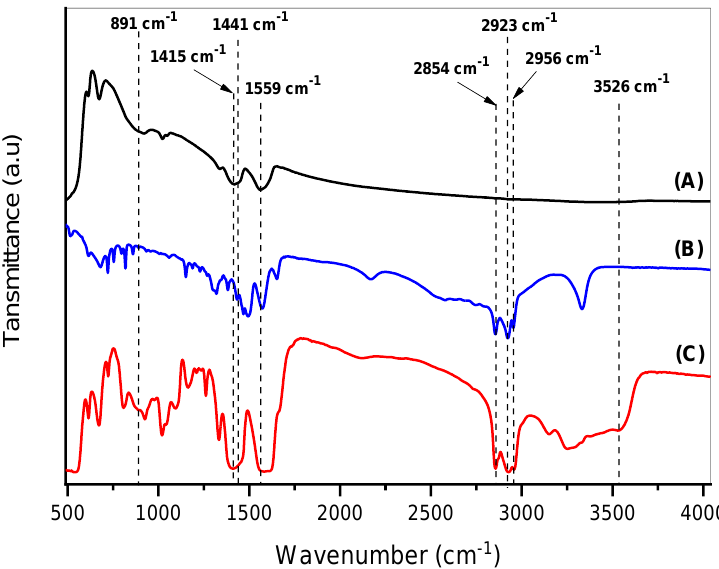
Figure 4: FTIR spectra of (A) ZnO film synthesized from zinc acetate precursor, (B) octylamine ligands with no treatment, (C) ZnO film showing in (A) after adding the octylamine ligands. Samples were deposited on GaAs